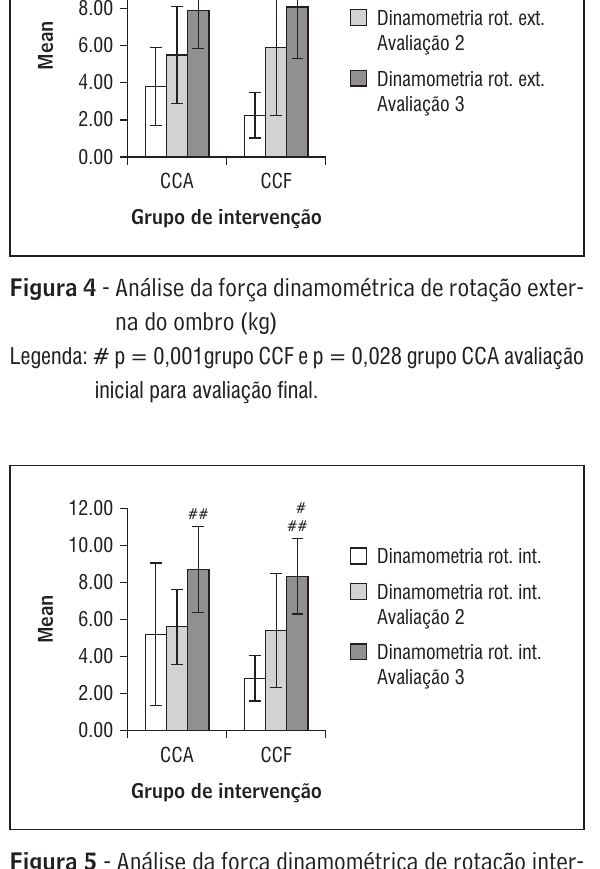
Figura 5 - Análise da força dinamométrica de rotação inter- na do ombro (kg) Legenda: # p = 0,001 avaliação inicial para avaliação fi nal; ## p = 0,04 grupo CCF e p = 0,009 grupo CCA avaliação parcial com dez sessões para avaliação fi